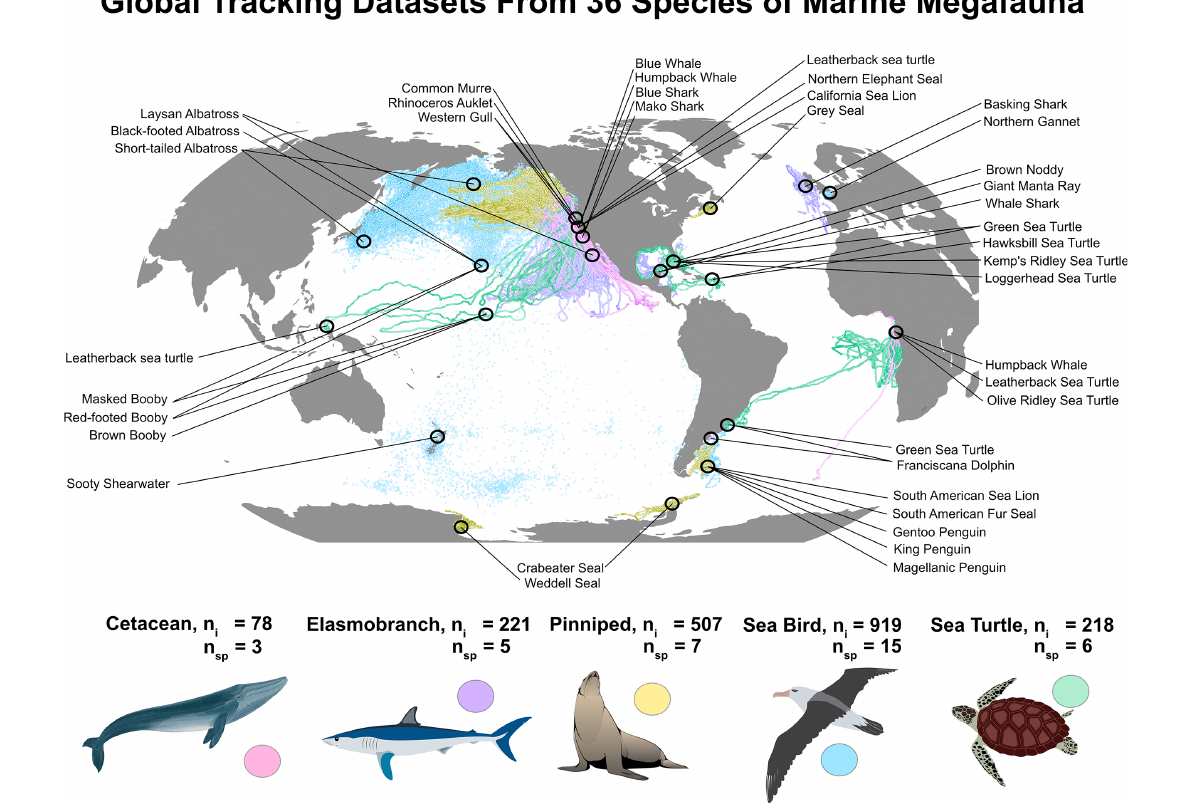
FIGURE 1 We gathered 43 tracking datasets from 1,943 individuals of 36 species representing five mobile marine taxa (elasmobranchs, cetaceans, pinnipeds, sea birds, and sea turtles). Location data were collected from marine vertebrates equipped with tracking devices (Argos satellite-linked (n=25), GPS (n=12), a combination of GPS+geolocation (GLS) (n=1, basking sharks), or GLS only (n=1, sooty shearwaters)) from four out of five of Earth’s five major oceans and from a few minor seas, gulfs, and channels between 2001-2018. Some species (n=4) were tracked with a mixture of Argos, GPS, and GLS